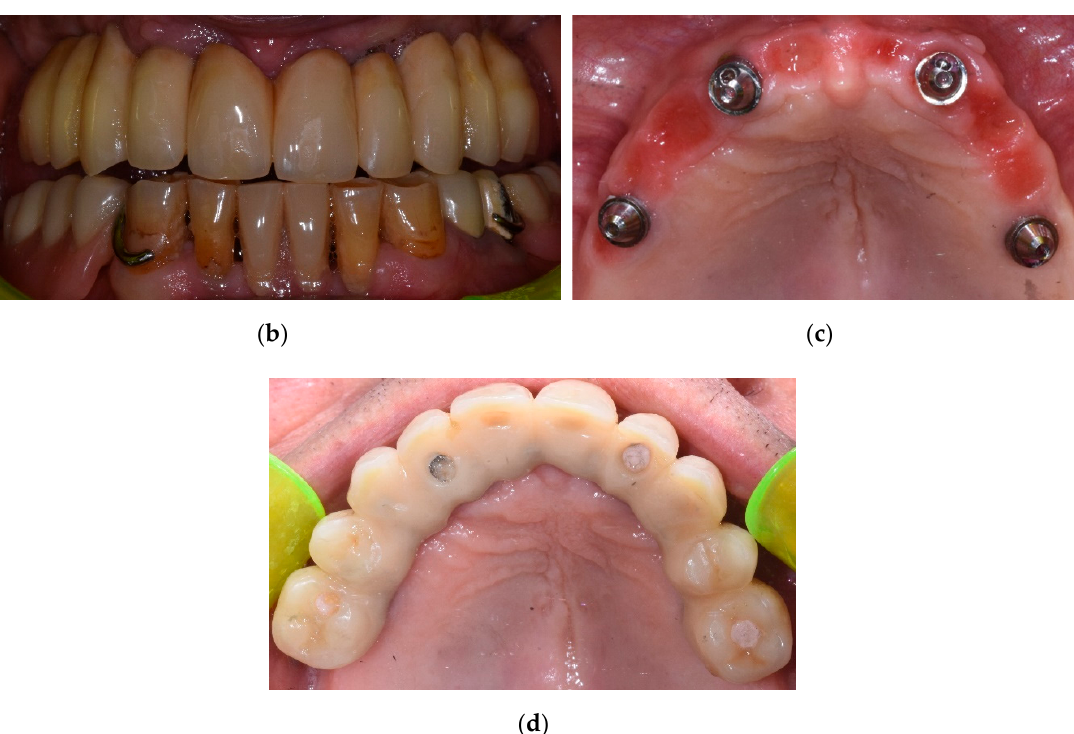
Figure 1. Panoramic radiograph of a full-arch immediate loading rehabilitation of the upper jaw according to the Columbus Bridge Protocol ( a ); frontal view ( b ) and occlusal intraoral views of the patient with ( d ) and without ( c ) prosthesis.